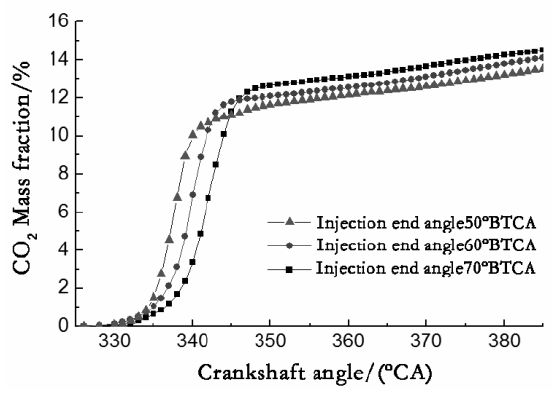
Figure 14. CO 2 curves corresponding to different injection end angles.